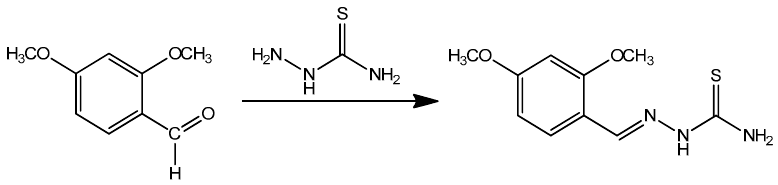
Figure 1. Nyquist plot for MS (Mild steel) in one normal sulfuric acid at various concentrations of